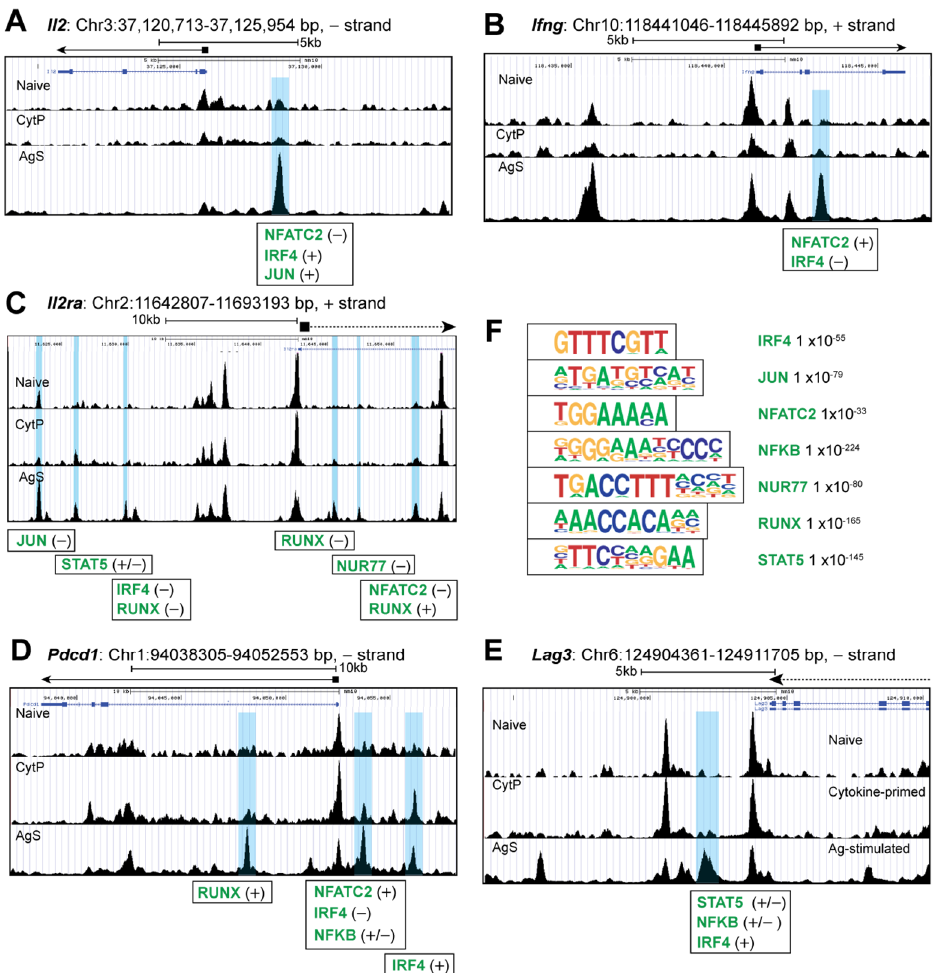
Figure 3. Chromatin accessibility in Ag-stimulated cells. Genome browser snapshots of chromatin accessibility signal at ( A ) Il2 , ( B ) Ifng and ( C ) Il2ra , ( D ) Pdcd1 and ( E ) Lag3 genes. The chromosomal locations of the genes, accessibility peaks opening only in AgS cells (shaded blue) and the corresponding transcription factor bindings sites are indicated. Position of genes are indicated by solid lines for full genes and dotted lines for partially covered genes within the genome area shown. The peak heights (FC signal) are adjusted to the same value for all three tracks before taking the snapshots. ( F ) The transcription factors binding motifs that are significantly enriched in chromosome accessibility peaks opening in AgS cells.